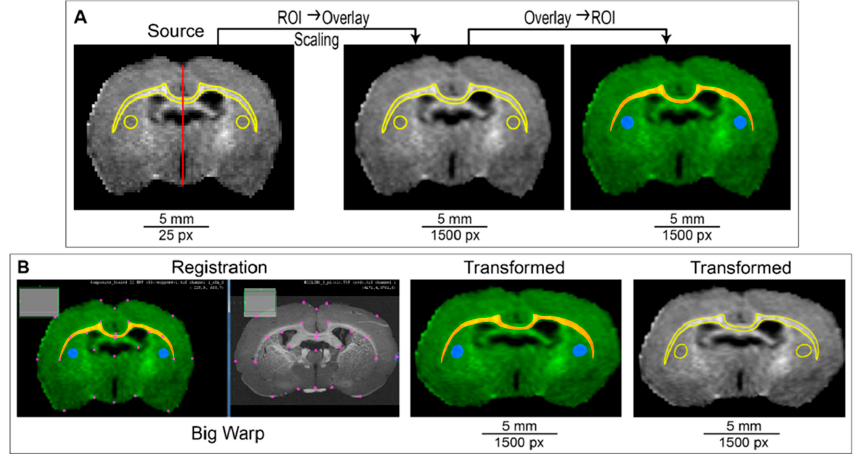
Figure 3. Steps 2–6 of the ROIT method. ( A ) Scaling of source image (step 2) and the creation of the RGB composite image (step 3). ( B ) Registration of the source MR image to target the histological image using the Big Warp tool and splitting a registered composite image into RGB channels to obtain transformed